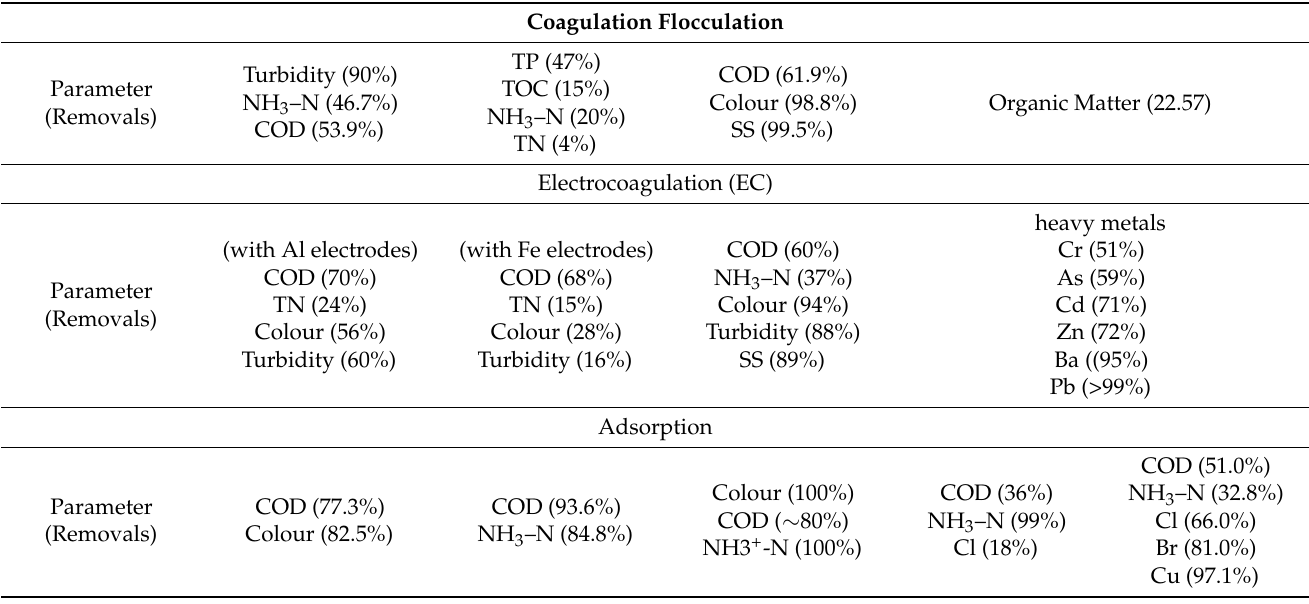
Table 3. An overview of various technologies in treating